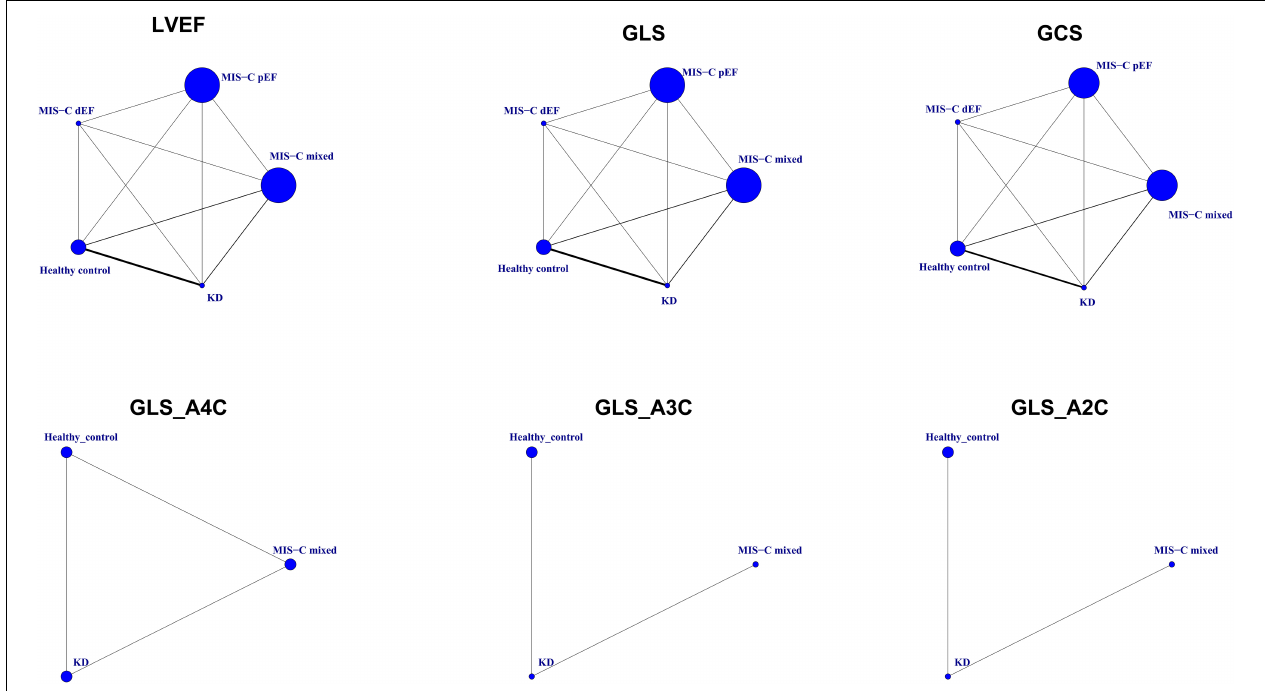
FIGURE 2 | Geometry of the network. Circles represent the intervention as a node in the network, size of circles corresponds to the number of participants included in each comparison, lines represent direct comparisons using studies, and the thickness of lines corresponds to the number of studies included in each comparison. GCS, global circumferential strain; GLS, global longitudinal strain; GLS_A2C, global longitudinal strain_apical two-chamber; GLS_A3C, global longitudinal strain_apical three-chamber; GLS_A4C, global longitudinal strain_apical four-chamber; KD, Kawasaki disease; LVEF, left ventricular ejection fraction; MIS-C, multisystem inflammatory syndrome in children; MIS-C dEF, Multisystem Inflammatory Syndrome in Children with depressed ejection fraction; MIS-C pEF, Multisystem Inflammatory Syndrome in Children with preserved ejection